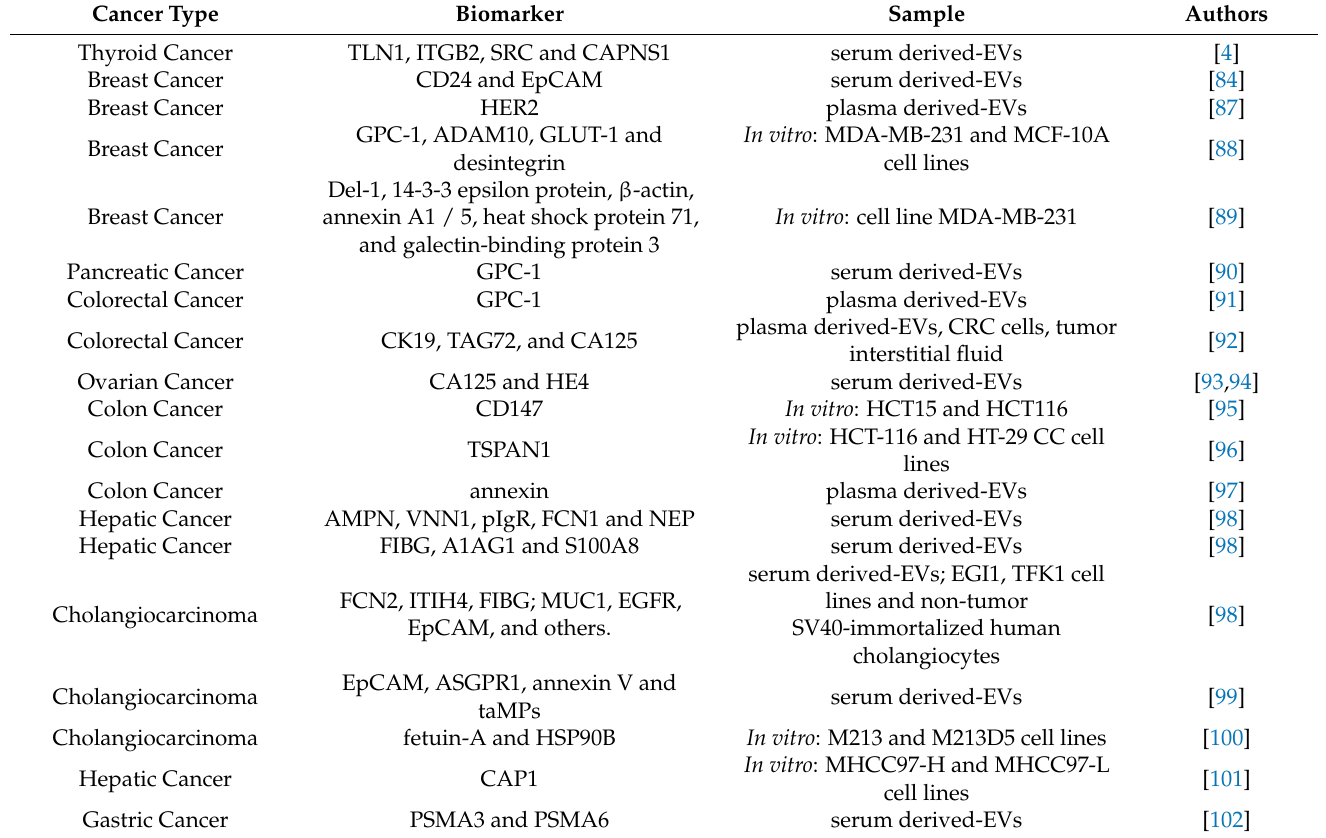
Table 1. Summary of the potential protein biomarkers identified in EVs from different cancer types. Cancer